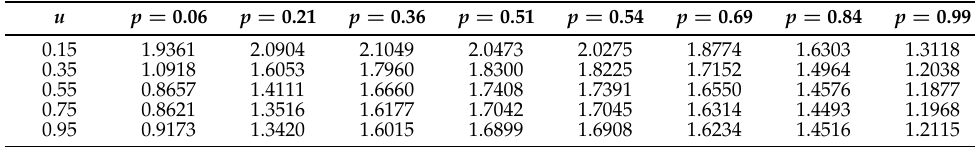
, ˆ β = 1 , ˆ d = π , λ 2 = 1 and p = 0.1, p = 2 2 4